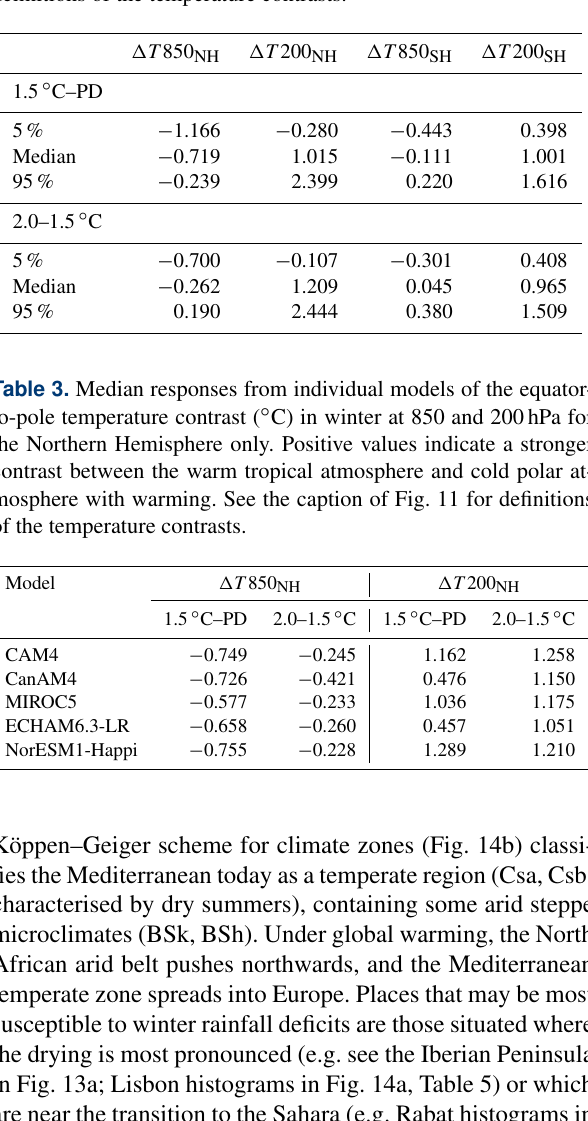
Table 2. Multi-model mean response of equator-to-pole temper- ature contrast ( ◦ C) in winter at 850 and 200hPa. The 5th per- centile, median, and 95th percentile responses are shown. The per- centile values and medians are first computed for each model; then a member-weighted multi-model mean is taken. Positive values indi- cate a stronger contrast between the warm tropical atmosphere and cold polar atmosphere with warming. See the caption of Fig. 11 for definitions of the temperature contrasts.